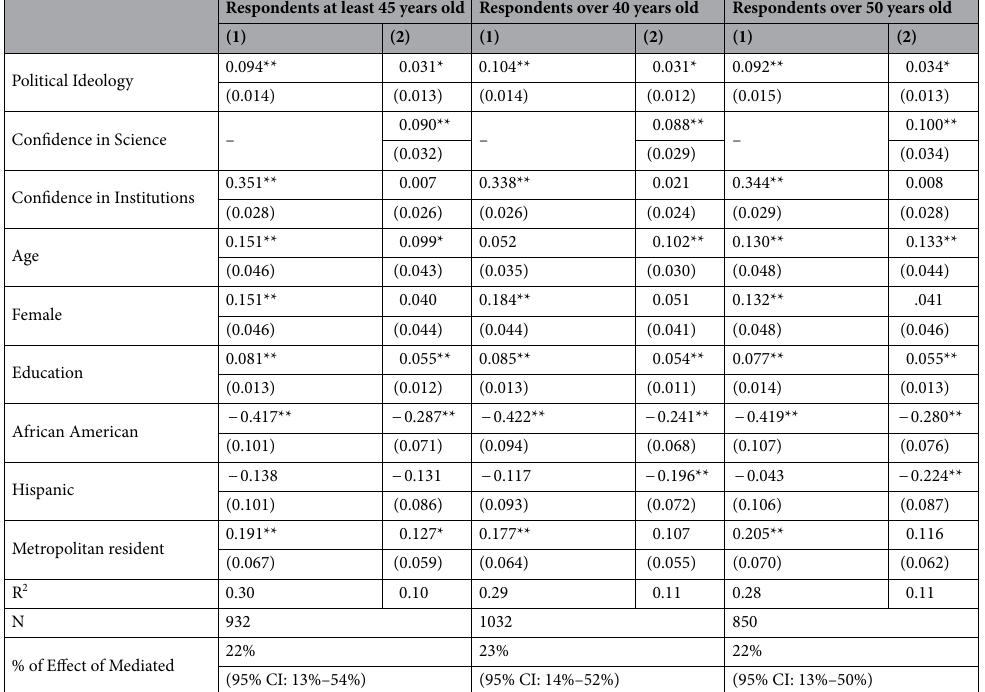
Table 2. Regression results for mediation analysis based on different age subsets of respondents. Each column presents ordinary least squares unstandardized regression coefficients with robust standard errors in parentheses. Column (1) corresponds to Eq. (1) of the mediation analysis ( Confidence in Science is the dependent variable). Column (2) corresponds to Eq. (2) in the mediation analysis ( Propensity to Participa te is the dependent variable). * p < 0.05; ** p < 0.01, two-tailed test.